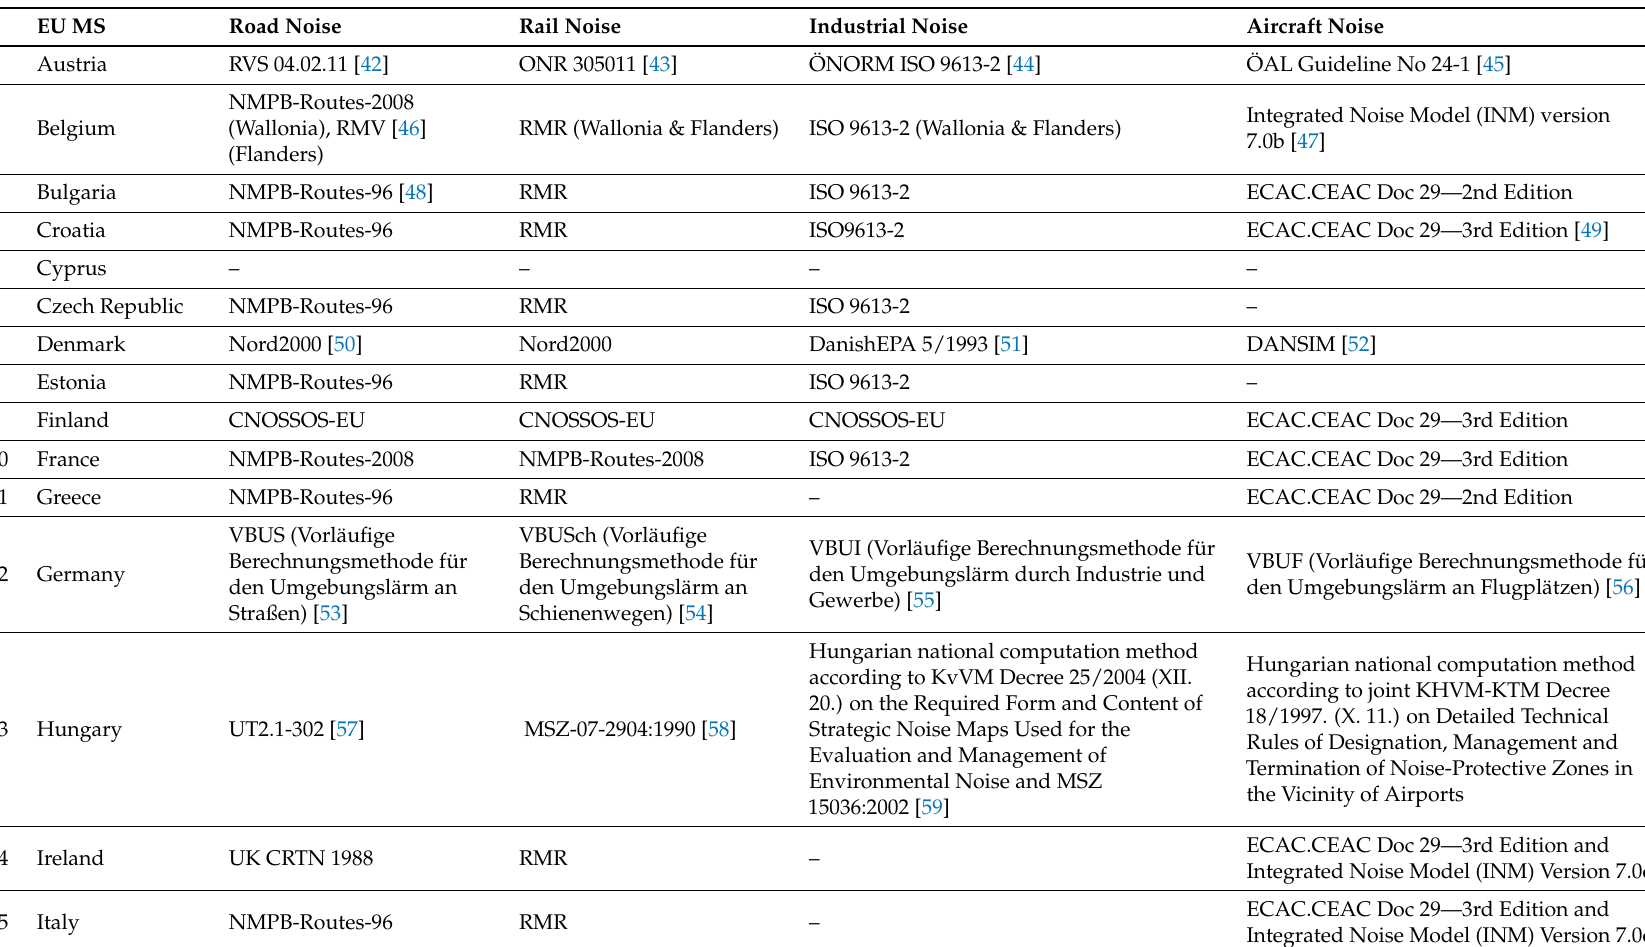
Table 1. Noise assessment methods and guidelines followed in the EU member states (MS) for the Round #3 of strategic noise mapping (2017) (Note: “–” means that data is not available.) (Src: